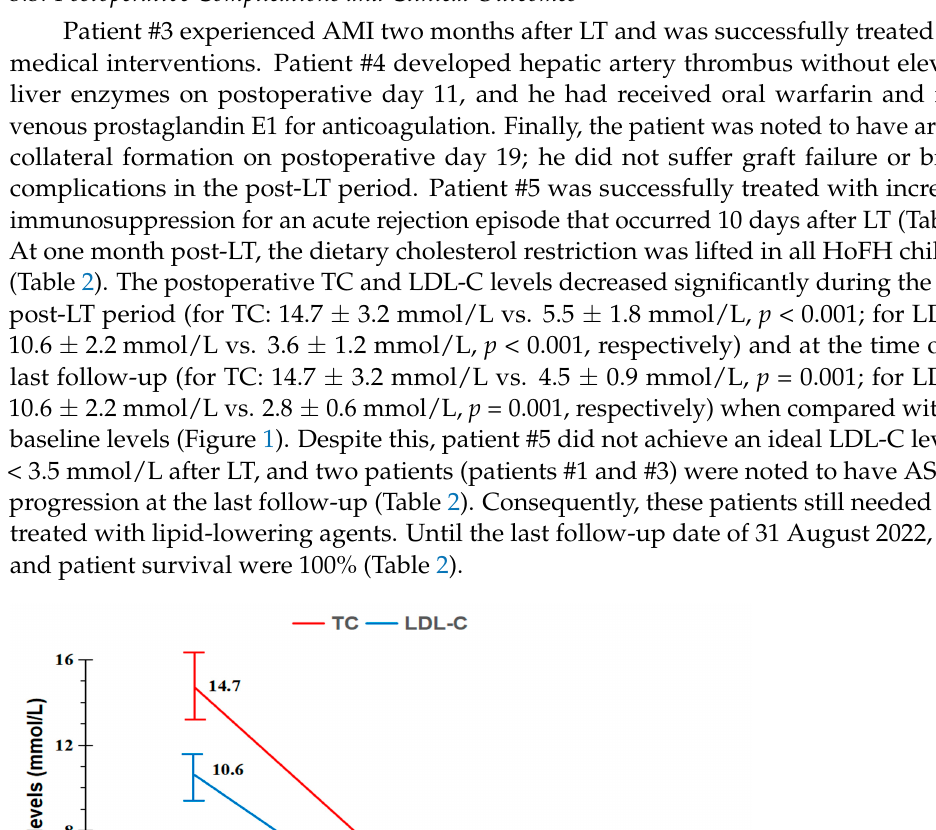
Latest TC levels: mean 4.5 mmol/L versus baseline levels: mean 14.7 mmol/L; p = 0.001. Post-LT LDL-C levels: mean 3.6 mmol/L versus baseline levels: mean 10.6 mmol/L; p < 0.001. Latest LDL-C levels: mean 2.8 mmol/L versus baseline levels: mean 10.6 mmol/L; p = 0.001. LDL-C low-density lipoprotein cholesterol, LT liver transplantation, TC total